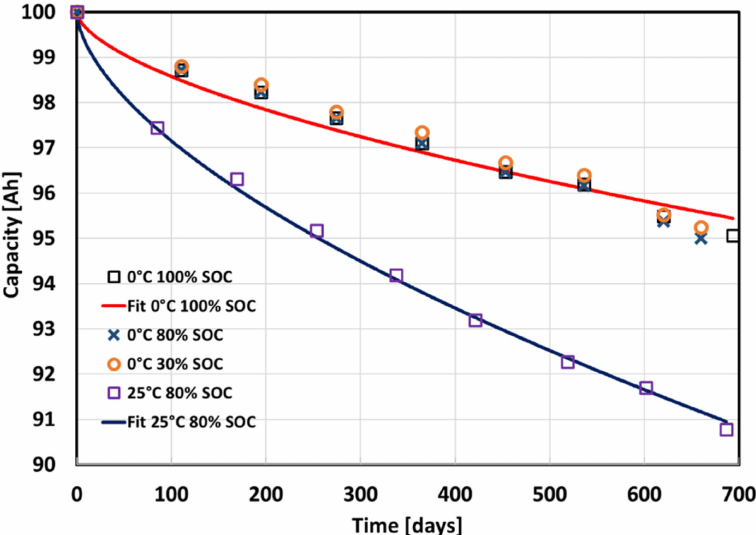
Figure 17. Calendar ageing data and curve fitting at 0 ◦ C and different SOC levels and 25 ◦ C and 80% SOC levels